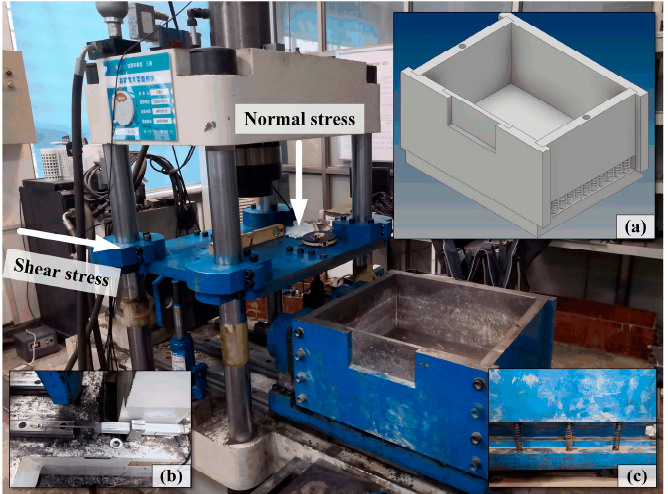
Figure 3. Large-scale shear instrument. ( a ) 3D schematic diagram of the shear box. ( b ) Displacement measuring device. ( c ) Spring under the shear box.